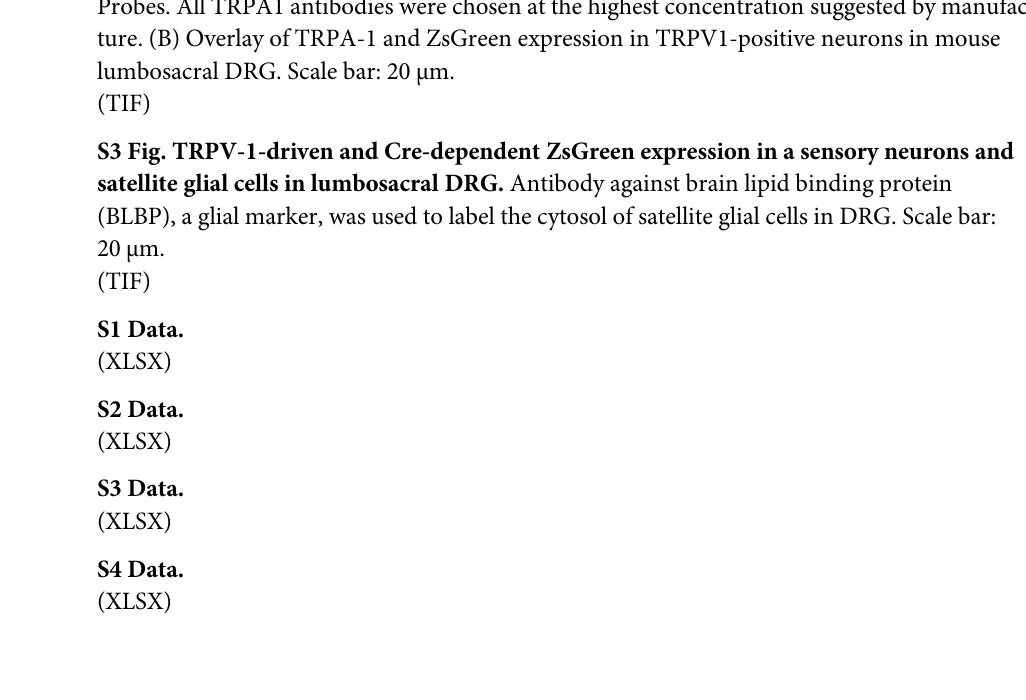
S2 Fig. Anti-TRPA1 antibody validation using immunofluorescence labeling in mouse